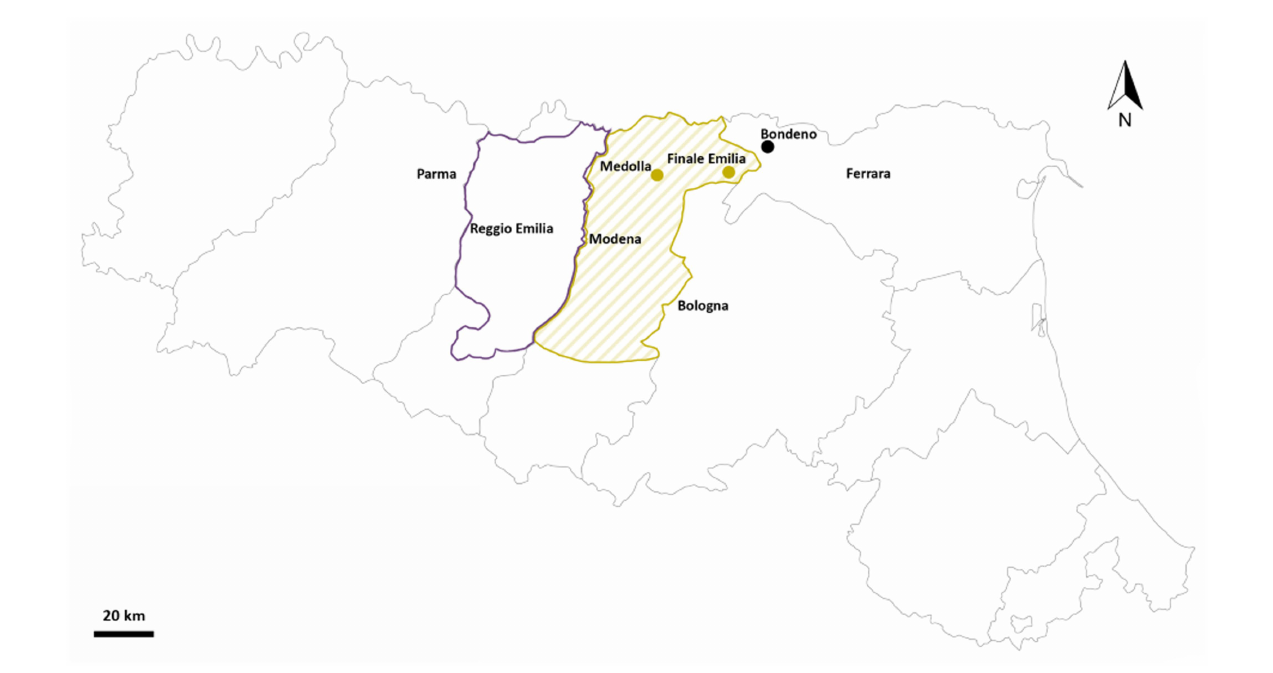
FIGURE 1 Sampling locations. Map of Emilia Romagna (Italy) showing the present study sampling sites in Bondeno (FE), Finale Emilia (MO) and Medolla (MO). Sampling locations are represented as yellow-green dots if located inside the Lambrusco DOC PDO viticultural area and as black dots if located outside the borders of such area. Borders of the entire “Consorzio Tutela Lambrusco DOC” are drawn (with a darker color for the Reggio Emilia territory and with a lighter color for the Modena